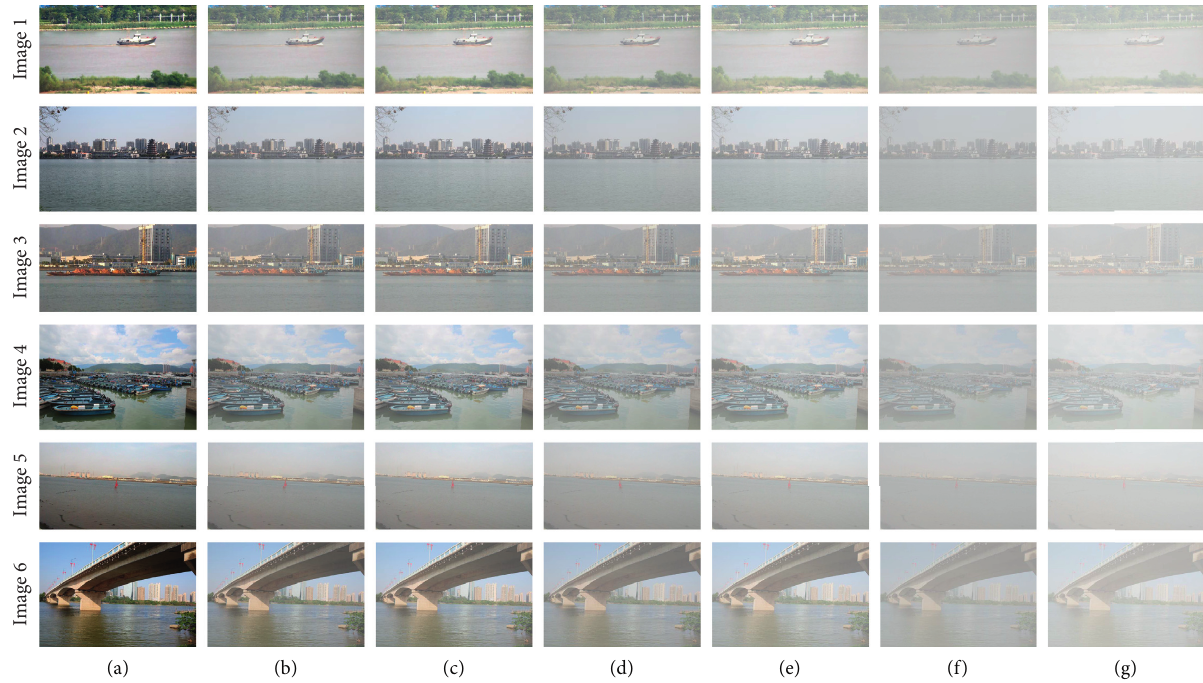
Figure 5: Six different original sharp maritime images selected to generate synthetic hazy images. From left to right: (a) original images; hazy � 0 . 8/ t � 0 . 6, (c) A � 0 . 9/ t � 0 . 6, (d) A images with (b) A ∞ ∞ 0 . 9/ t � 0 . 2,